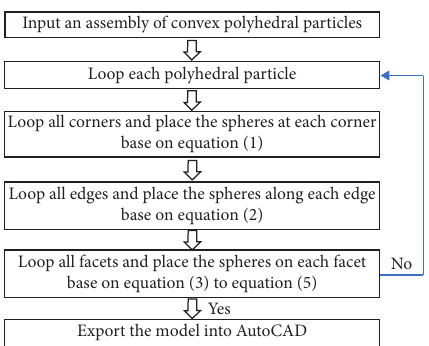
Figure 5: A flowchart of clump generation for an assembly of convex polyhedral particles by the proposed